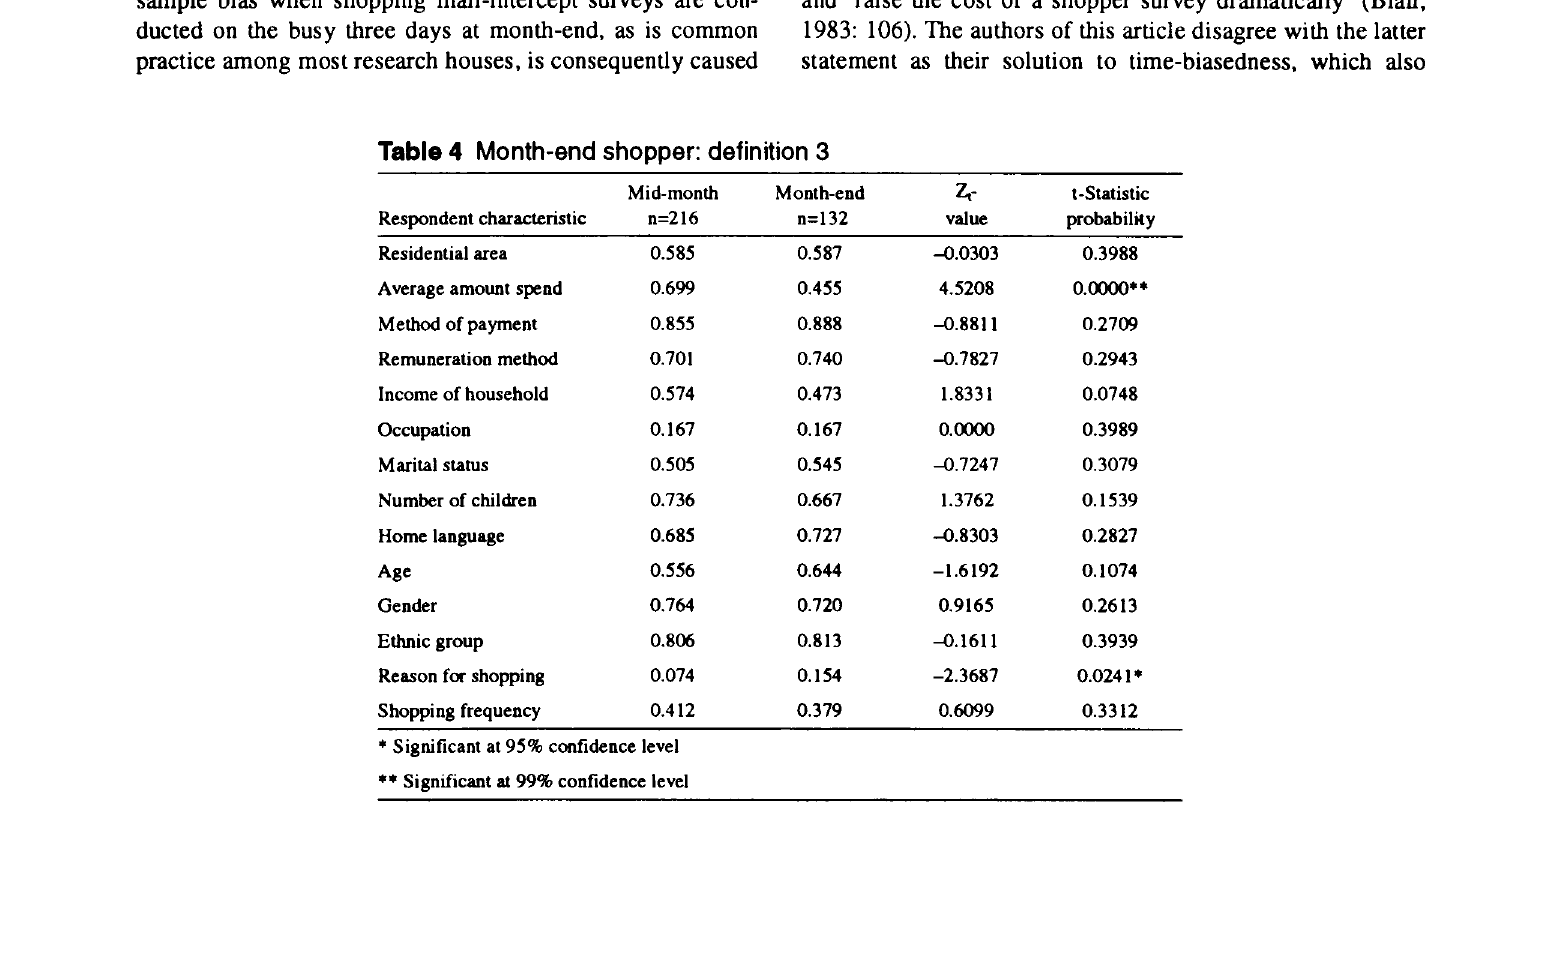
Table 4 Month-end shopper: definition